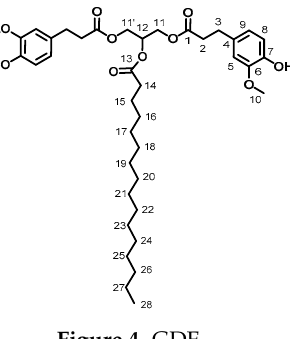
Figure 4. GDF 14. Figure 4. GDF 14.